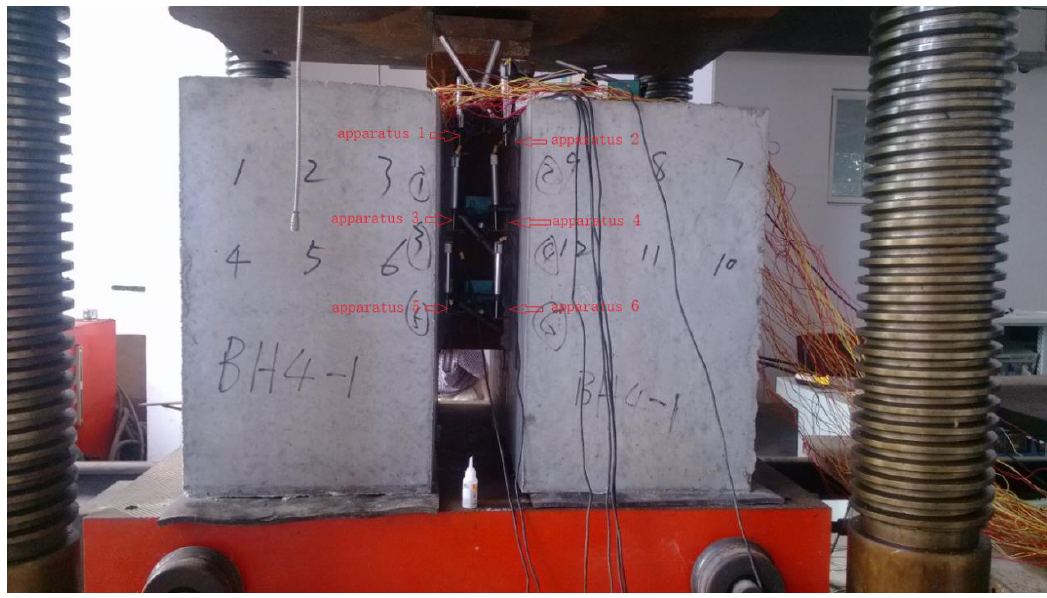
Figure 3. Dimensions of push-out specimens and perforated rib: BH-PP (unit: mm).